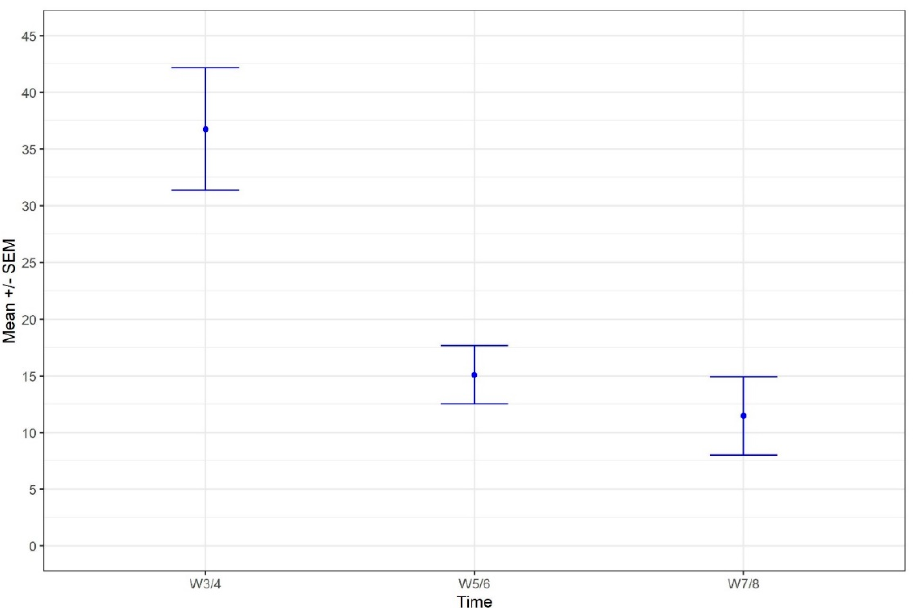
Figure 1 . Evolution of the proportion of time dedicated to nurse throughout the weaning period (% of total video observation time, n = 25 bitches).